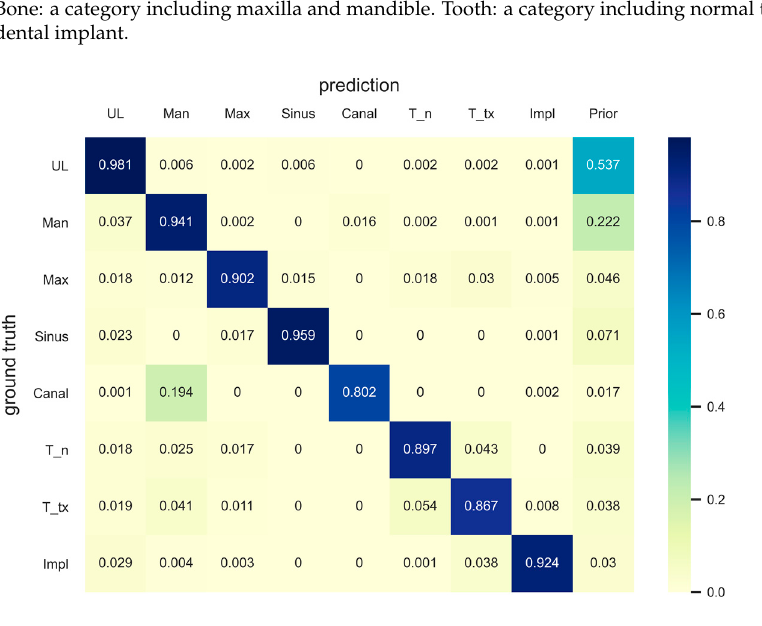
Table 4. Average precision (AP) for all the “thing”